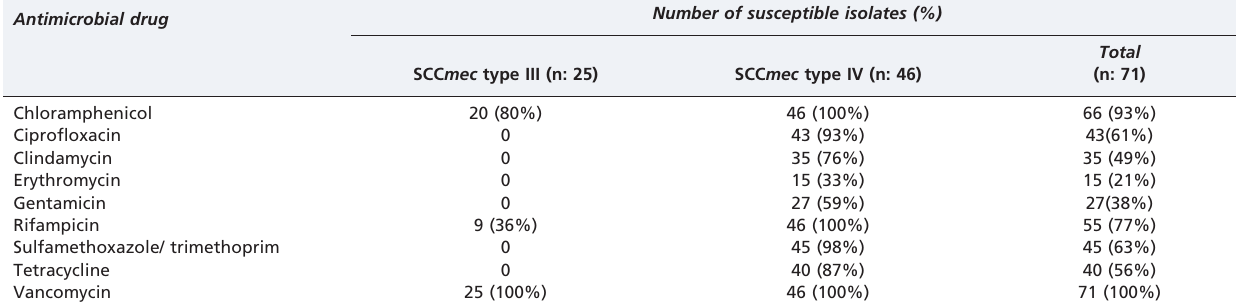
Table 5 - Antimicrobial susceptibility according to SCC mec type of 71 MRSA isolates that colonized 60 patients and 11 healthcare workers in the dermatology unit over a period of 6 months. Antimicrobial